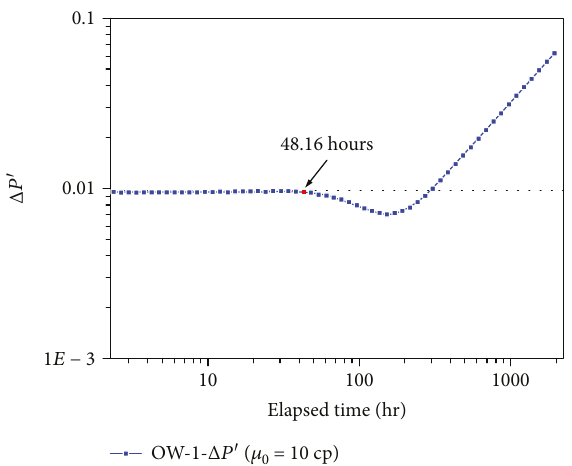
Figure 7: The log-log plot of drawdown of a closed system which shows that the pressure derivative starts to decrease at 48.16 hours. At this point, the pressure reached transition